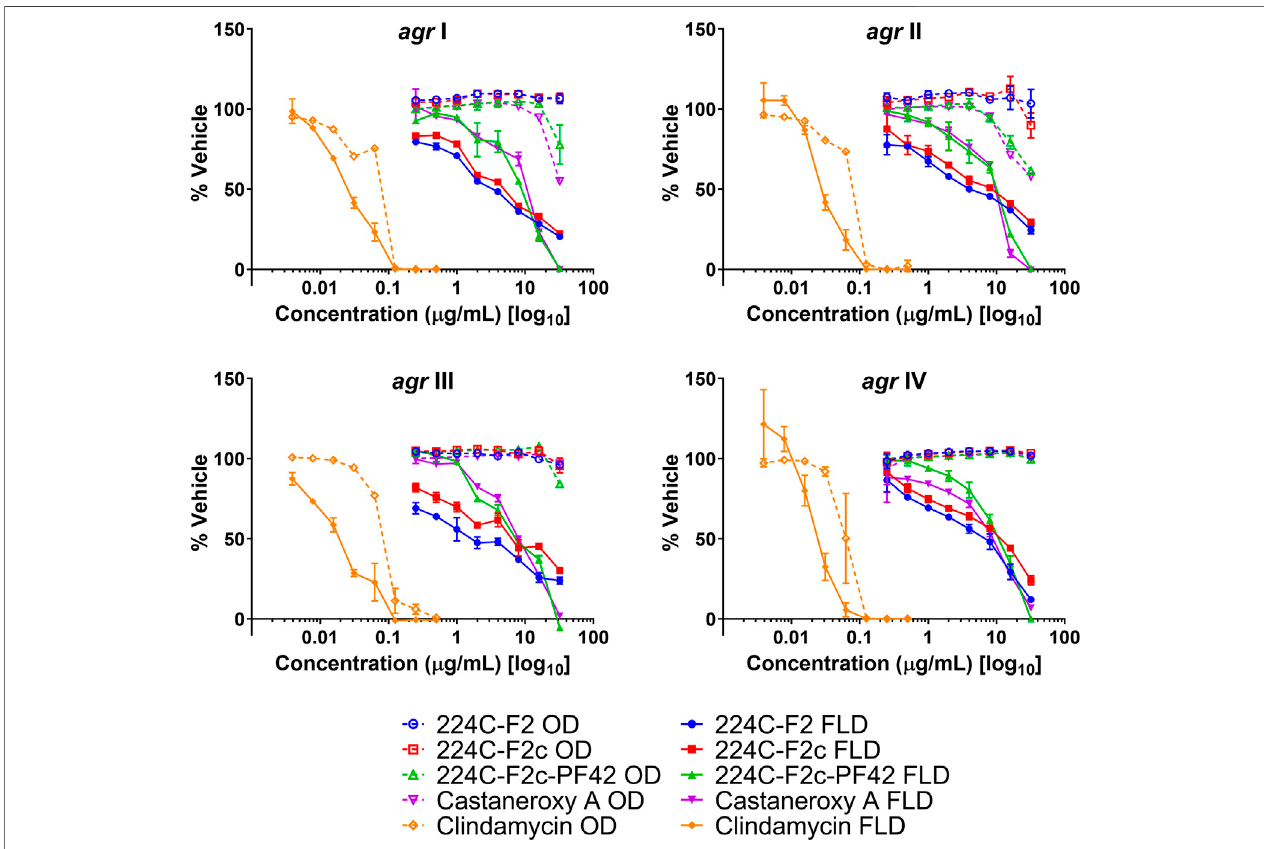
FIGURE 5 | Castaneroxy A ( 1 ) and its parent fractions exert selective concentration-dependent inhibition of agr ::P3 activation in all agr sub-types at 18 h post- inoculation. These were tested from 0.25 – 32 µg/mL on four S. aureus agr ::P3 reporter strains: AH1677 ( agr I), AH430 ( agr II), AH1747 ( agr III), AH 1872 ( agr IV). All dashed linesrepresentopticaldensity(OD)values,indicatinggrowth; allsolidlinesrepresent fl uorescencedetection(FLD)values,indicatingintensityofYFPdetectionas a result of agr ::P3 activation. Clindamycin was used as a positive control for growth inhibition.